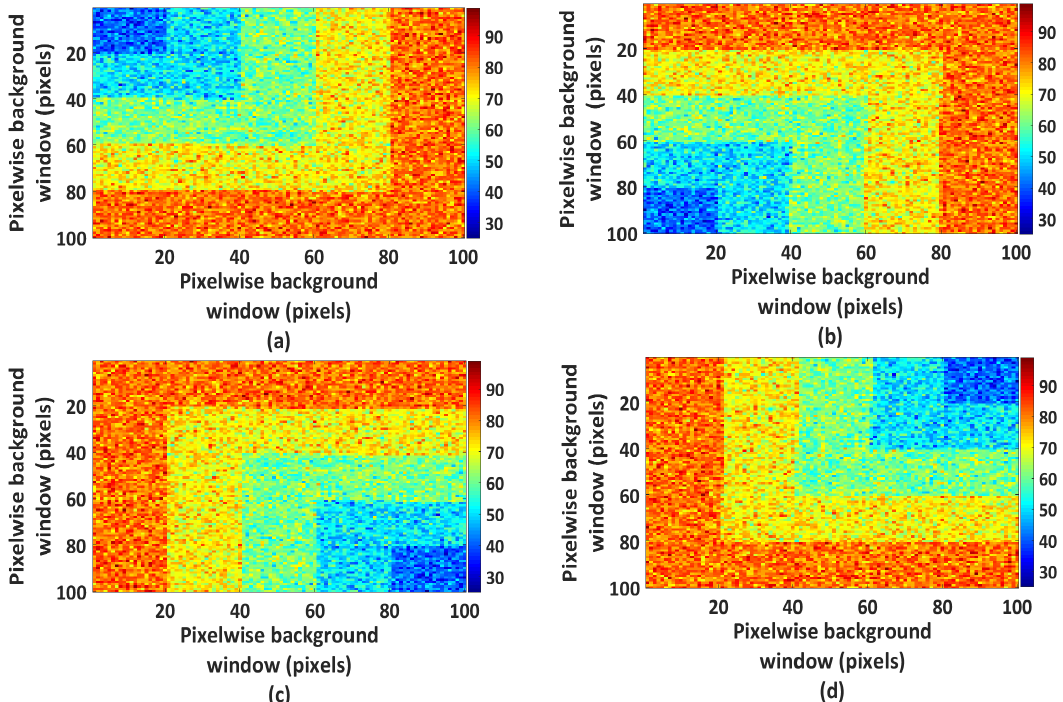
Figure 16. Pixelwise perturbation to the spatial variability of the background window with diagonal variation ( a ) top left to bottom right; ( b ) bottom left to top right; ( c ) bottom right to top left; ( d ) top right to bottom